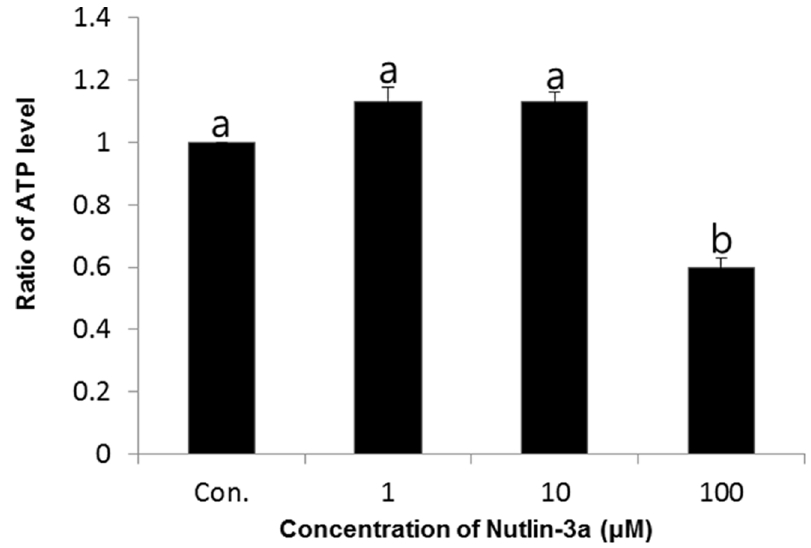
Figure 3. Effects of nutlin-3a on ATP production in spermatozoa. Data are expressed as the mean ± SEM, n=3. Values with different superscripts ( a,b ) indicate significant differences between control and treatment groups on one-way ANOVA ( p <0.05).